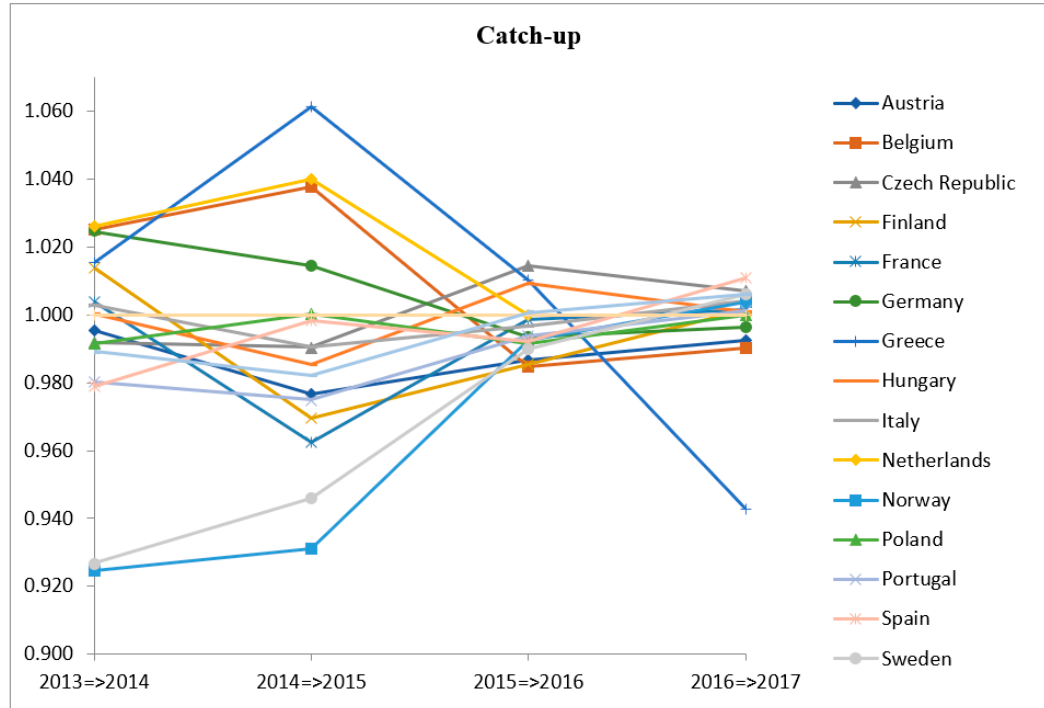
Figure 2. Year-on-year efficiency changes from 2013 to 2017.